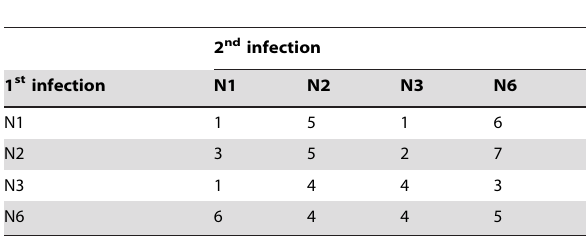
Rows show first infection and columns later infections.